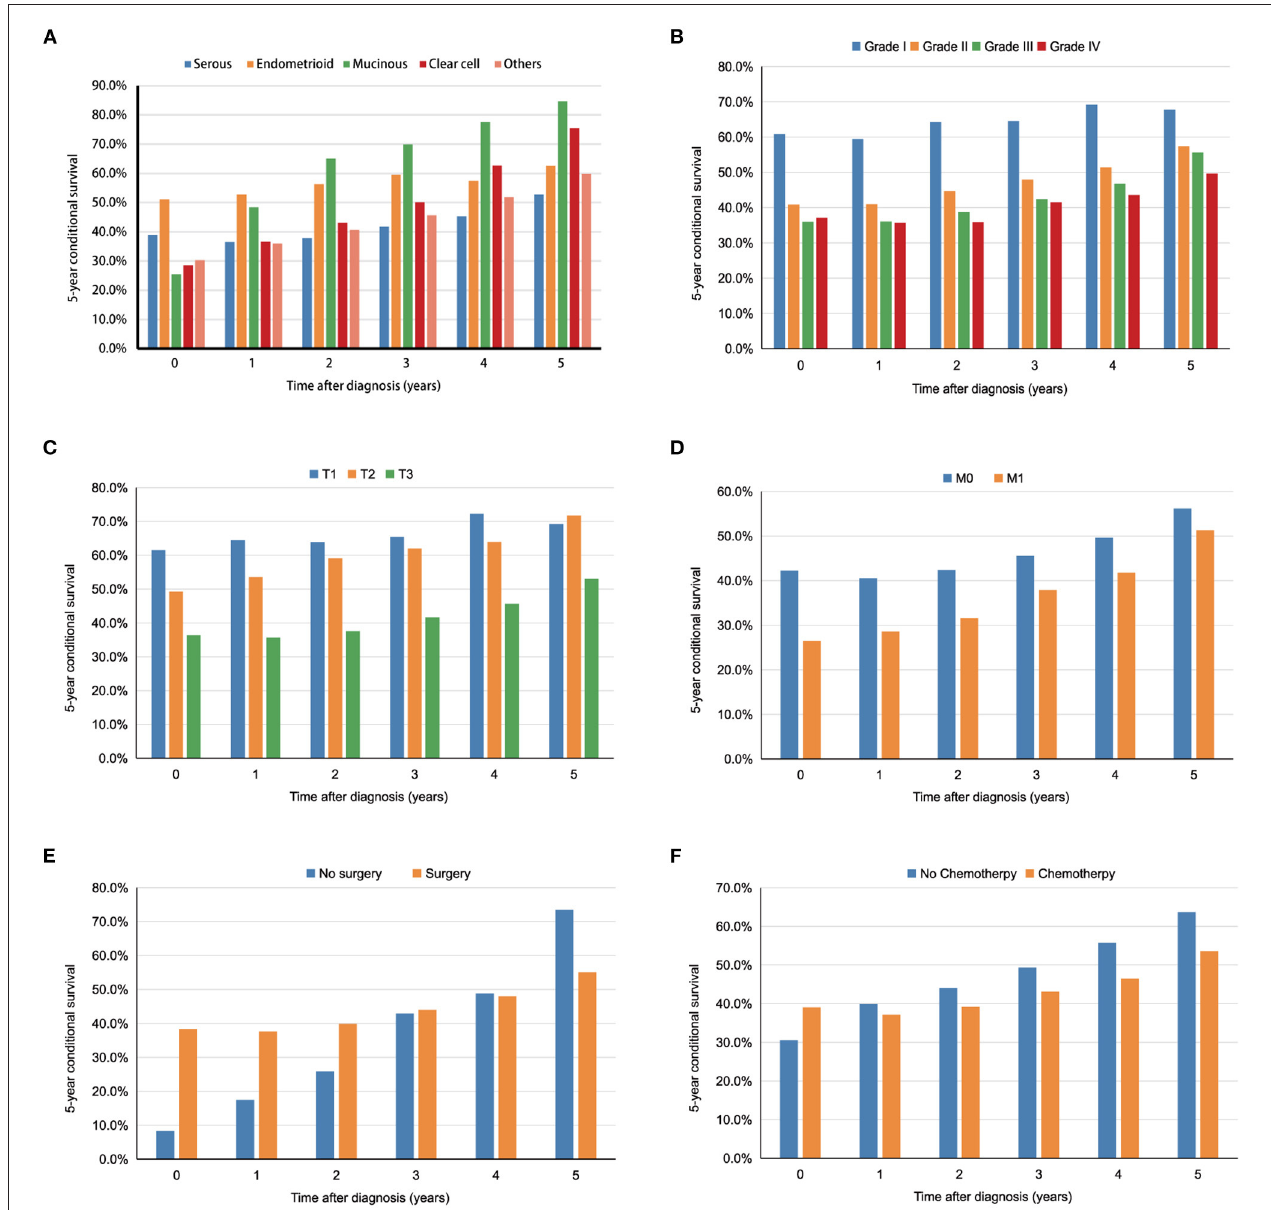
FIGURE 3 | The 5 year conditional survival (CS5) among subgroups divided by histological types (A) , tumor grade (B) , T stage (C) , M stage (D) , surgery (E) , and chemotherapy (F) .